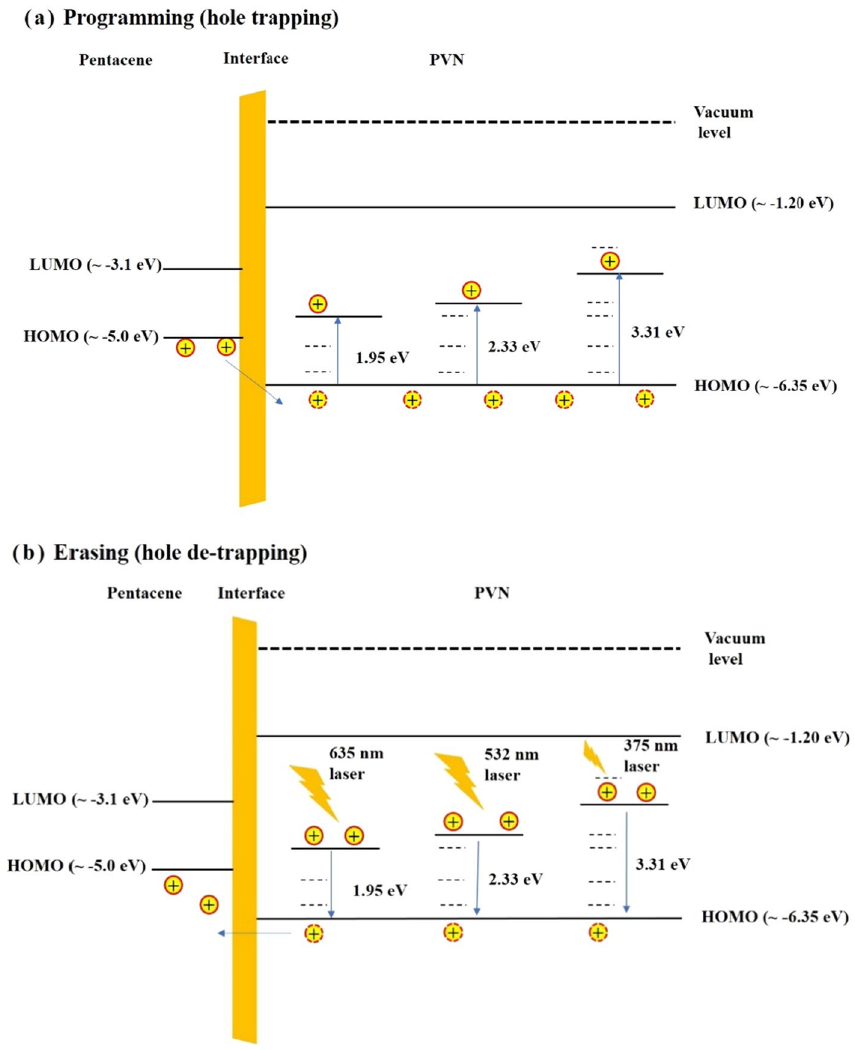
Figure 6. The energy band diagram of ( a ) hole trapping, and ( b ) hole de-trapping processes under photon irradiation with different wavelengths in PVN layer in pentacene